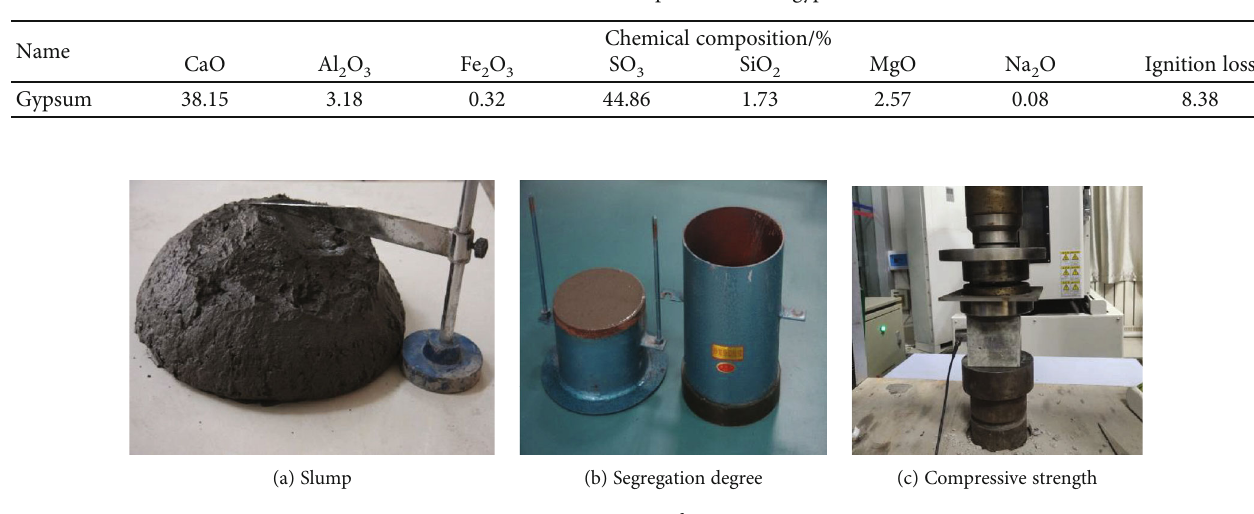
Figure 6: Measurement of test parameters. Table 3: Results of the orthogonal test and paste parameter test.